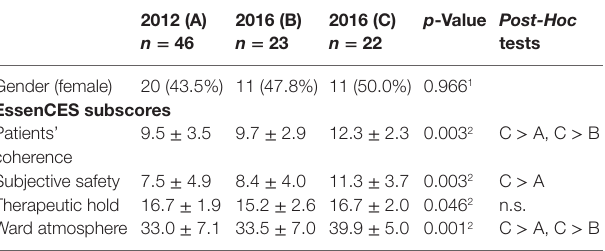
taBle 2 | Effect of prior anti-aggression and de-escalation (ADE) training.